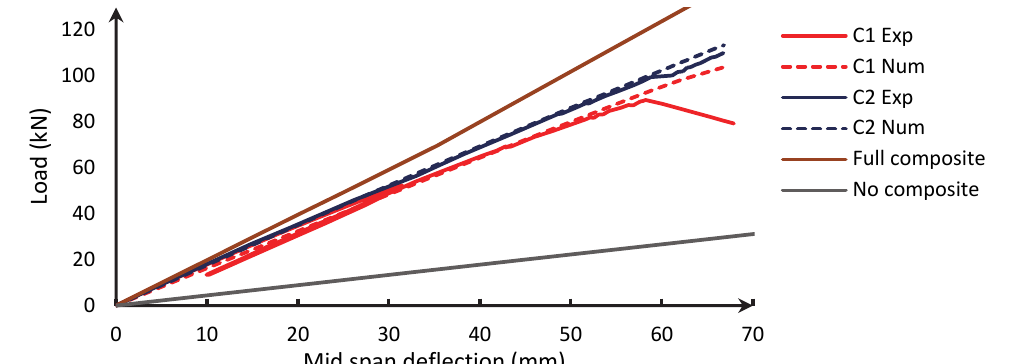
Figure 11: The load-mid-span deflection curves of the TCC beams C1 and C2 with Triangular notch connections compared with the experimental curves .